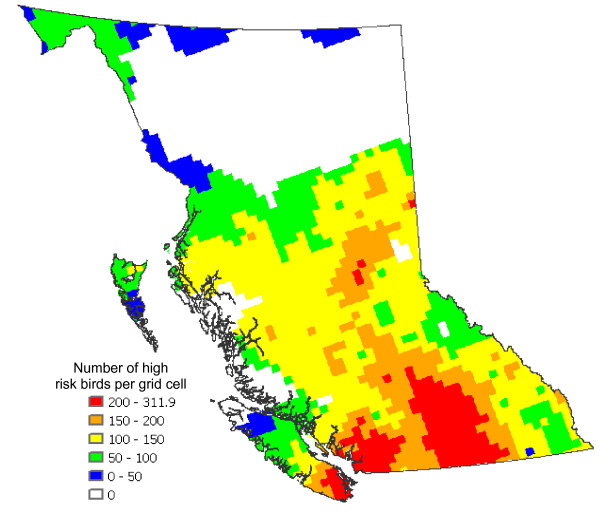
Total abundance of high risk bird species in breeding season. The map shows the average number of individual birds considered to be high risk species by the BCCDC (see the additional file for species considered in the map).